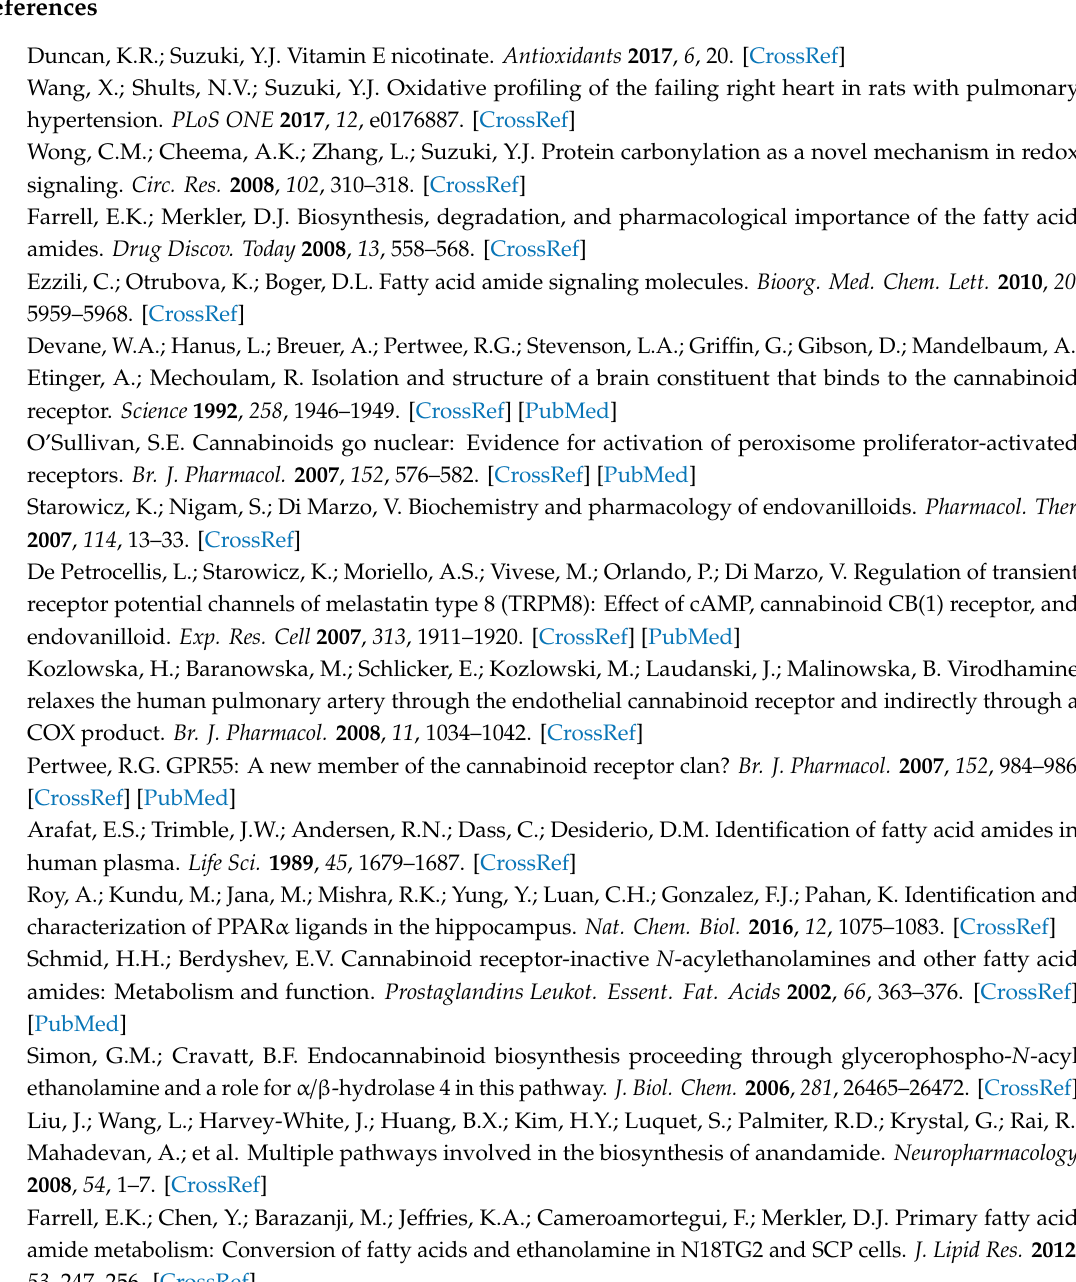
Figure S1: Total ion chromatograms, File S1: List of masses identified to be di ff erentially a ff ected by TN vs. TA + N that correspond to lipids, File S2: List of masses identified to be di ff erentially a ff ected by TN vs. TA + N that correspond to